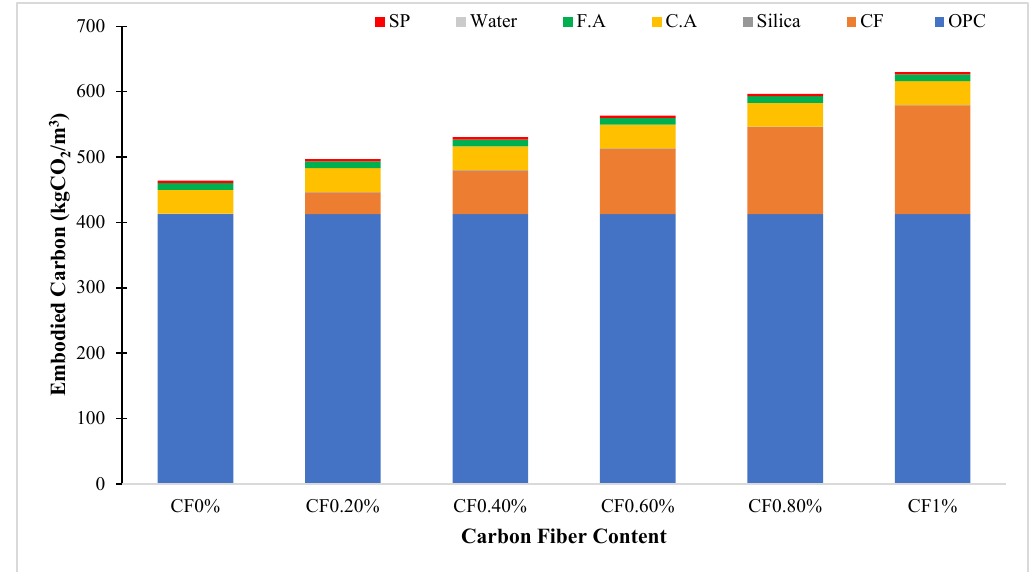
Figure 11. Embodied carbon.